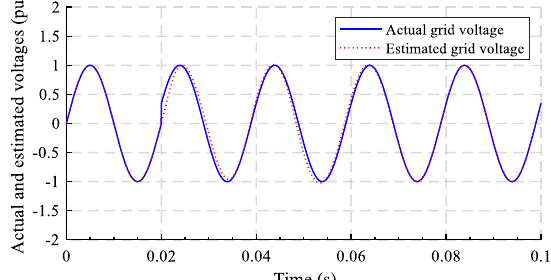
Fig. 4 Actual (solid) and estimated (dashed) grid voltages (pu) under a 20° phase jump at 0.02